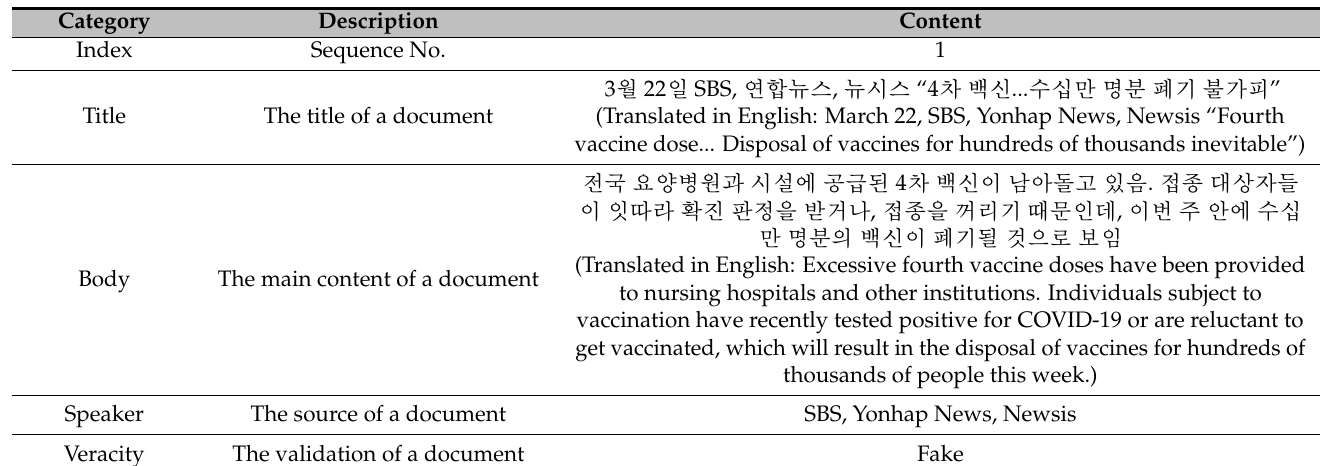
Table 1. An example of datasets extracted from fact-checking websites.